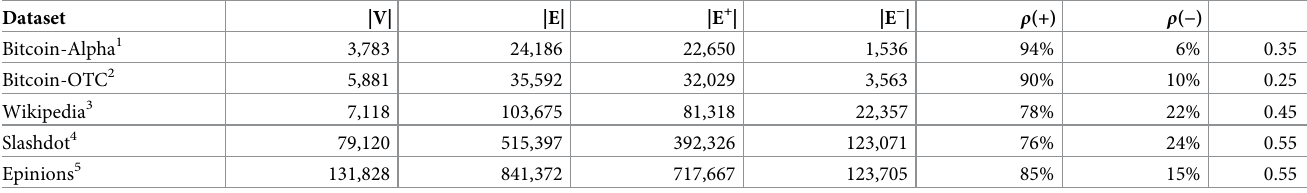
Table 2. Dataset statistics of directed signed graphs. |V| and |E| are the number of nodes and edges, respectively. Given sign s 2 {+, − }, |E s | and ρ ( s ) are the number and percentage of edges with sign s , respectively. The local injection ratio is denoted by c .